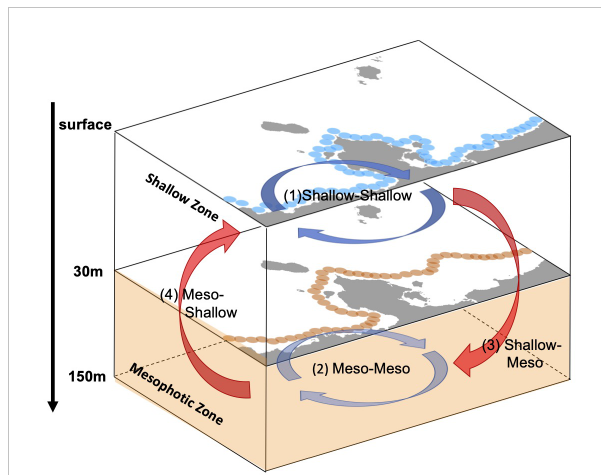
FIGURE 7 Schematic diagram of four types of the horizontal and vertical connectivity between the shallow corals and the mesophotic corals. Blue and orange circles are the source patches used for Case 1 (Figure 1C) and Case 2 (Figure 1D), respectively. In this study, the shallow zone is de fi ned from the surface down to 30 m depth, while the mesophotic zone is from 30 m to 150 m depths. Mesophotic is abbreviated to “ Meso ” here. See also Table